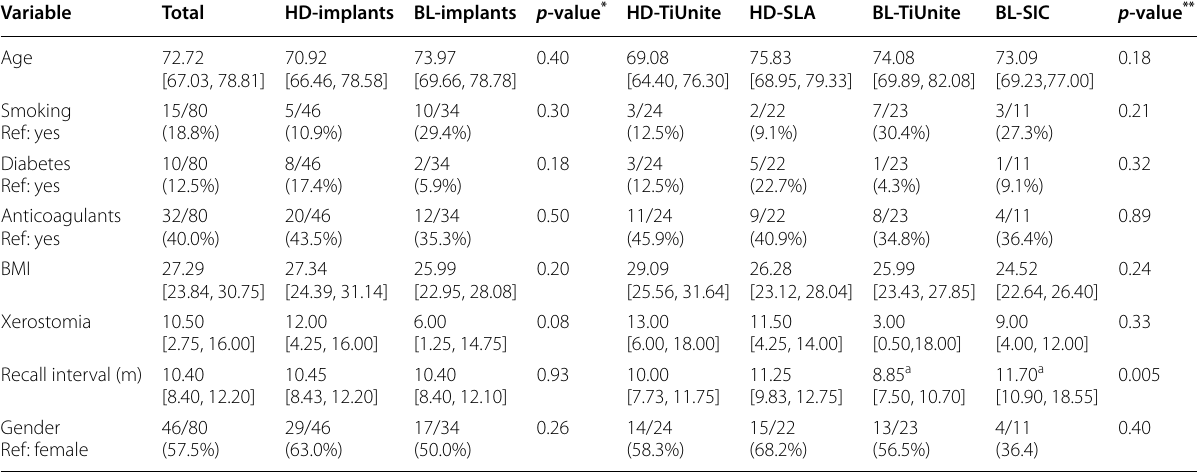
* P-value comparing HD- with BL-implants, ** P-value comparing implant types. a Groups with same letter show statistically significant post hoc tests Table 3 Differences of tested parameters and possible risk factor by implant‑level and implant‑type